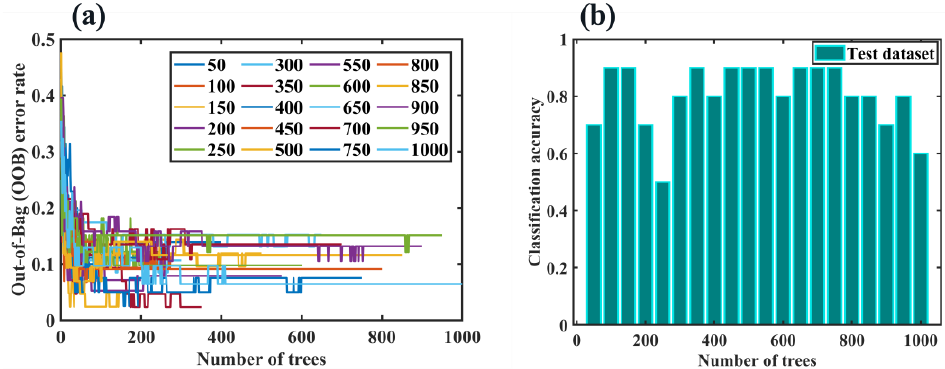
Figure 10. ( a ) OOB error rate and ( b ) classification accuracy with different numbers of DTs.